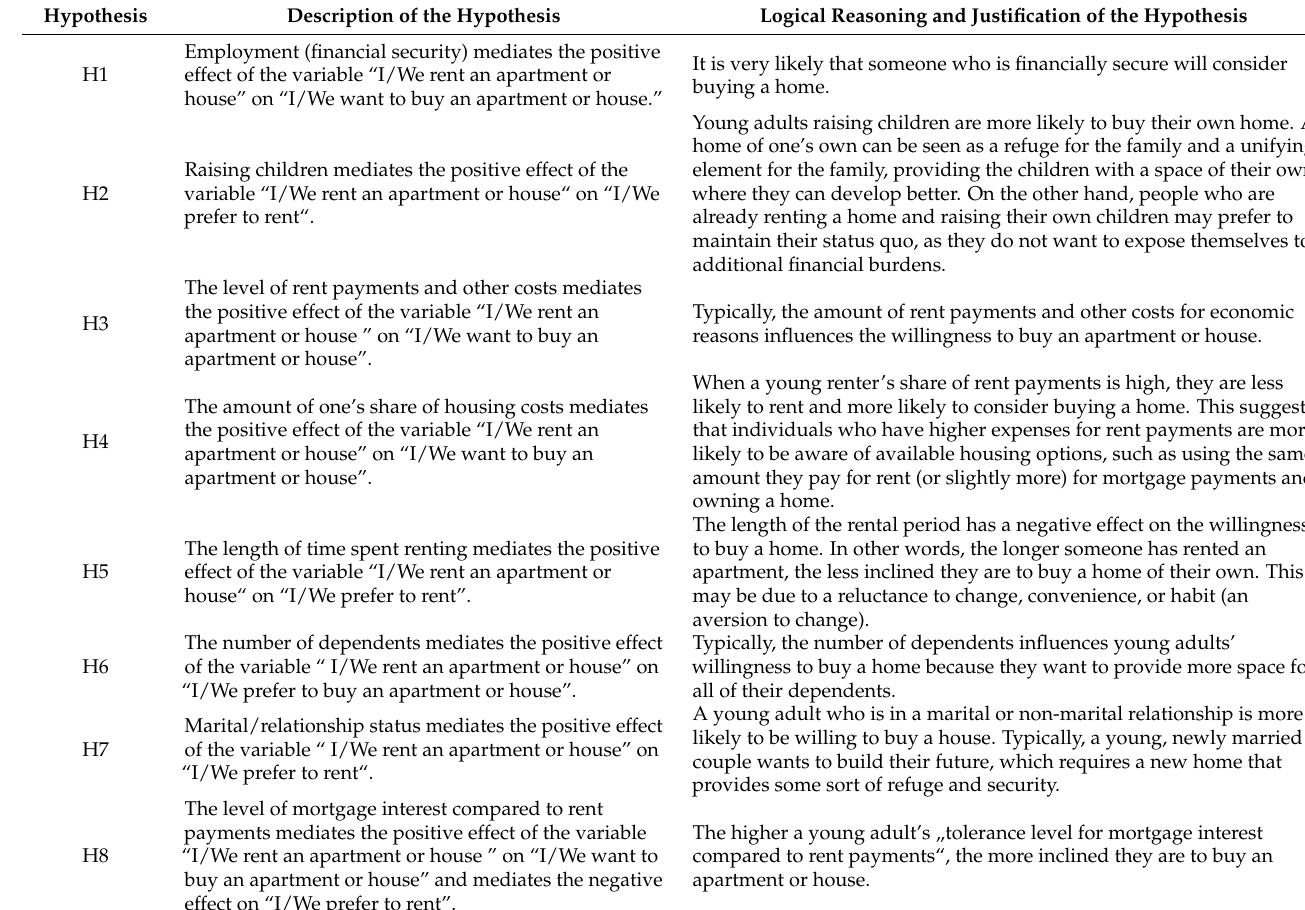
Table 2. Research hypotheses based on the literature and existing